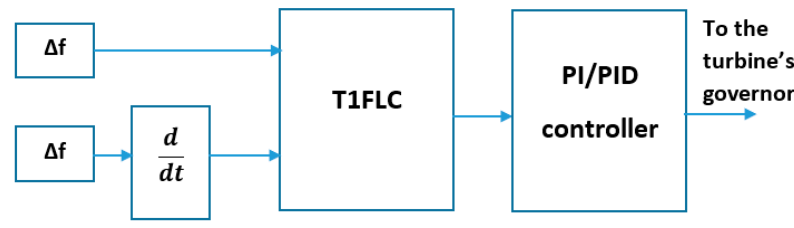
Figure 5. Block diagram of the fuzzy controller.